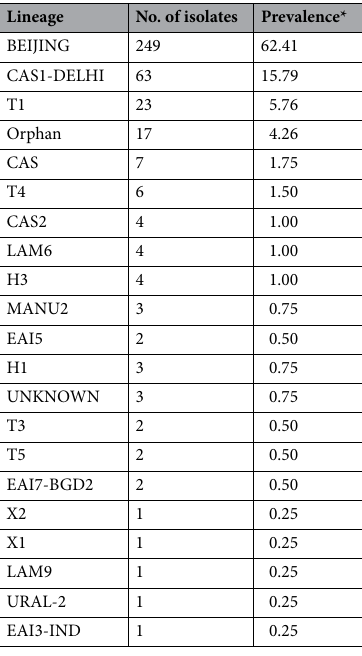
Table 1. Distribution of different lineages of 399 MTBC isolates collected from 2016 to 2018 based on the spoligotype classification by SITVIT2. *Values are in %.